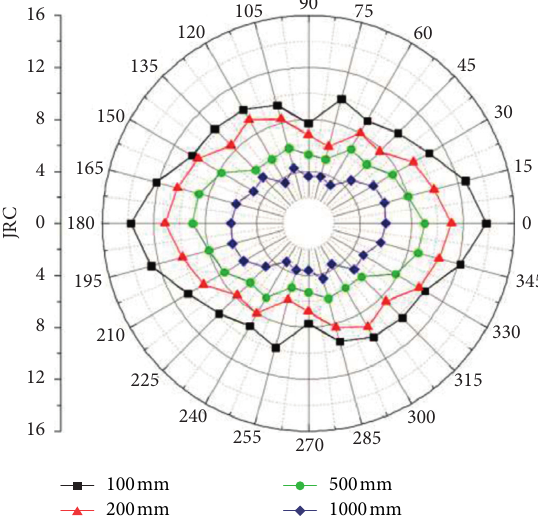
Figure 4: Polar plots of JRC values of different sized roughness surfaces.